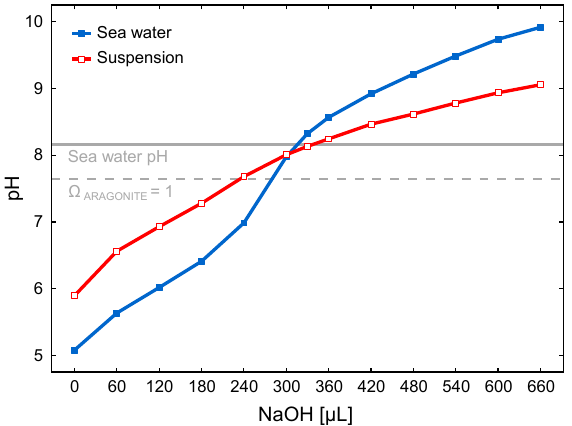
Figure 4. Titration of 500mL sea water (blue, filled box and line) and 500 mL particle suspension (red, empty box and line) with 3M NaOH after addition of 150µL 2.4M FeCl 3 solution. The grey solid line indicates the pH of seawater before any manipulation. pH (NBS scale) was measured at 25 ◦ C with a stationary pH meter (713, METROHM). Calculated aragonite saturation state of (cid:127) = 1 is rep- resented by the grey dashed line.